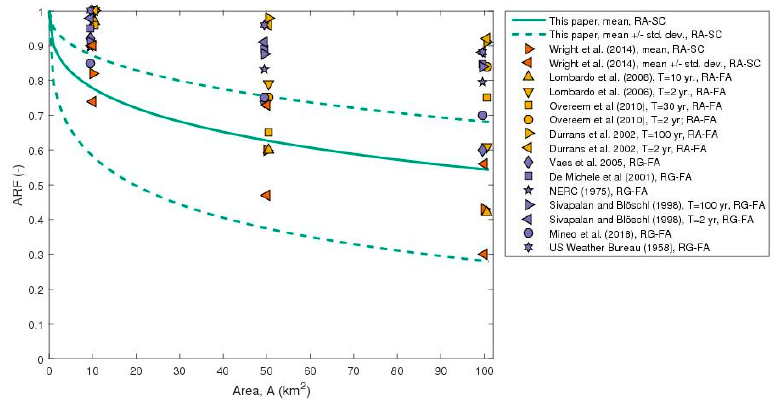
Figure 8. Derived ARF relationship for 60 min durations compared to previous studies for areas of 10, 50 and 100 km 2 estimated using fixed-area (FA) and storm-centred (SC) approaches applying both rain gauge (RG) and radar data (RA).